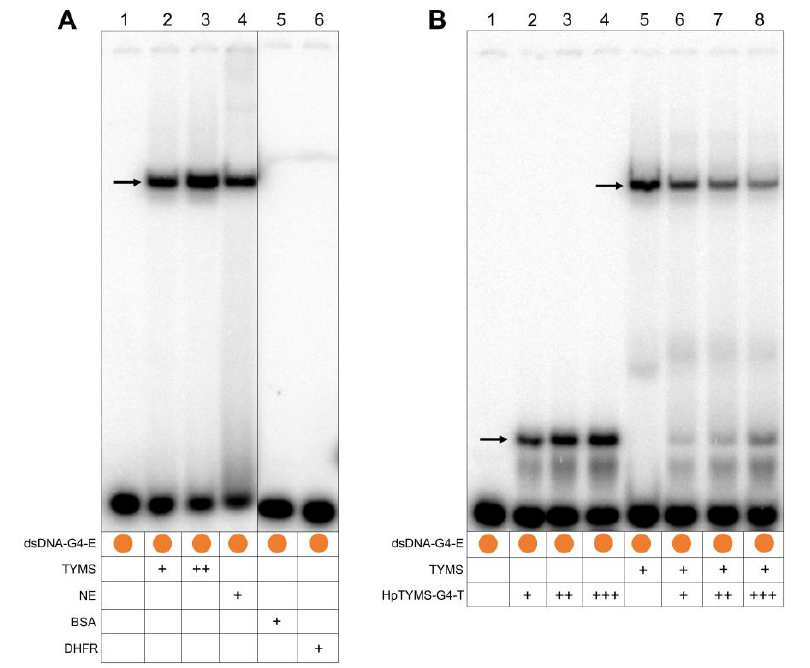
Figure 4. Binding of TYMS protein to the 32 P-radiolabeled dsDNA probe corresponding to the G4FS. ( A ) Lane 1, dsDNA-G4-E probe alone; lane 2, dsDNA-G4-E plus TYMS protein (1.5 µ g); lane 3, dsDNA-G4 plus TYMS protein (3 µ g); lane 4, dsDNA-G4-E plus HeLa nuclear protein extract (NE) (2 µ g); lane 5, dsDNA-G4-E plus BSA protein (2 µ g); lane 6, dsDNA-G4-E plus DHFR protein (2 µ g). ( B ) Competition assay between the TYMS protein and the HpTYMS-G4-T for the binding to the G4FS in the dsDNA. Lane 1, dsDNA-G4-E probe alone; lane 2, dsDNA-G4-E plus HpTYMS-G4-T (10 ng); lane 3, dsDNA-G4-E plus HpTYMS-G4-T (30 ng); lane 4, dsDNA-G4-E plus HpTYMS-G4-T (60 ng); lane 5, dsDNA-G4-E plus TYMS protein (1.5 µ g); lane 6, dsDNA-G4-E plus TYMS protein (1.5 µ g) competed with HpTYMS-G4-T (10 ng); lane 7, dsDNA-G4-E plus TYMS protein (1.5 µ g) competed with HpTYMS-G4-T (30 ng); lane 8, dsDNA-G4-E plus TYMS protein (1.5 µ g) competed with HpTYMS-G4-T (60 ng). Arrows indicate the shifted bands corresponding to the di ff erent molecular